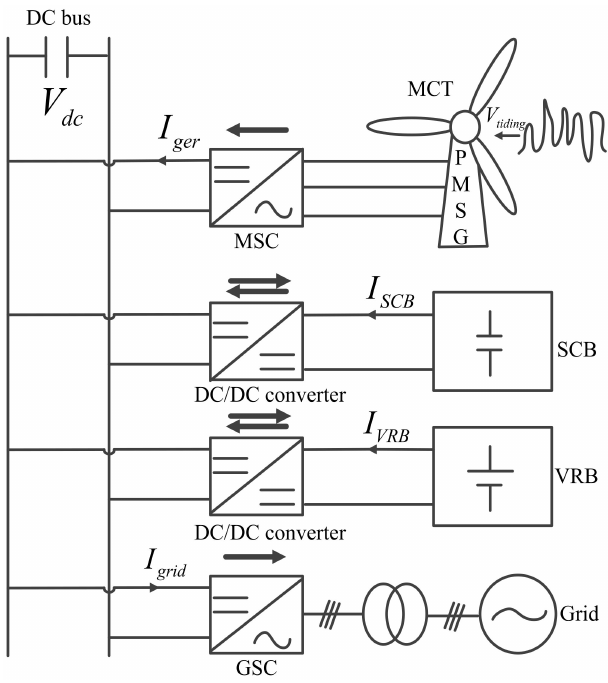
Figure 1. System